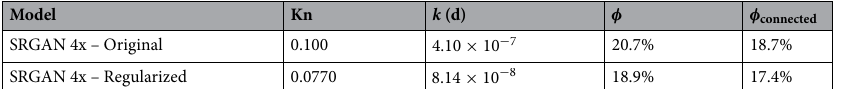
Table 2. Image similarity metrics for volume generation. Metric represents the KL divergence between the distribution of image features computed for the test set image patches and slices from each image plane for synthesized volumes. Lesser is better for all metrics shown. Statistics are computed over 5 total 128 For the area and perimeter, the z regularization and post-processing decrease performance for the x – y plane and produce similar results for the orthogonal x – z and y – z planes. Both z -regularization and post-processing show a significant improvement for the Euler characteristic results.